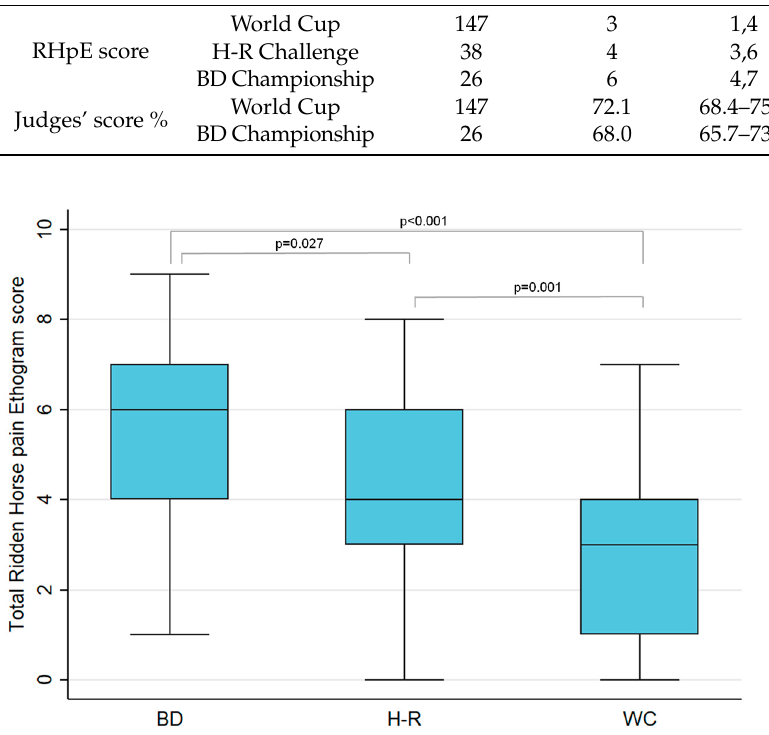
Figure 2. Total Ridden Horse Pain Ethogram scores (out of 24) for competitors at the British Dressage Grand Prix National Championship (BDC) ( n = 26), the Hickstead-Rotterdam Challenge (HRC) ( n = 38) and the World Cup Western League qualifying competitions and the finals ( n = 147) (WC) [10]. There were significant differences between each of the competitions as determined by the Kruskal-Wallis and post-hoc Dunn’s test. Boxes represent the medians and interquartile ranges while whiskers represent the range.